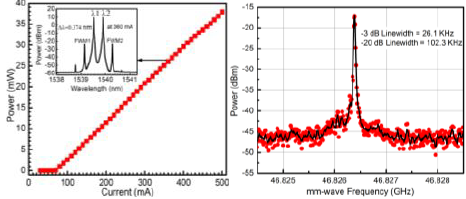
Fig. 4 . L-I characteristics (inset shows the optical spectrum at 360 mA) and their generated MMW